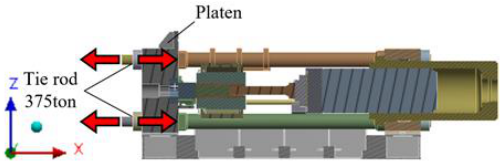
Figure 3. Tie rod load conditions.